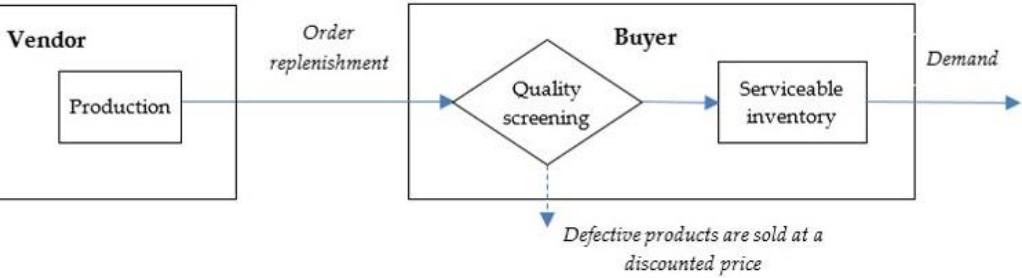
Figure 1. Illustration of an integrated inventory model for imperfect quality items where defective products are sold at a discounted price.